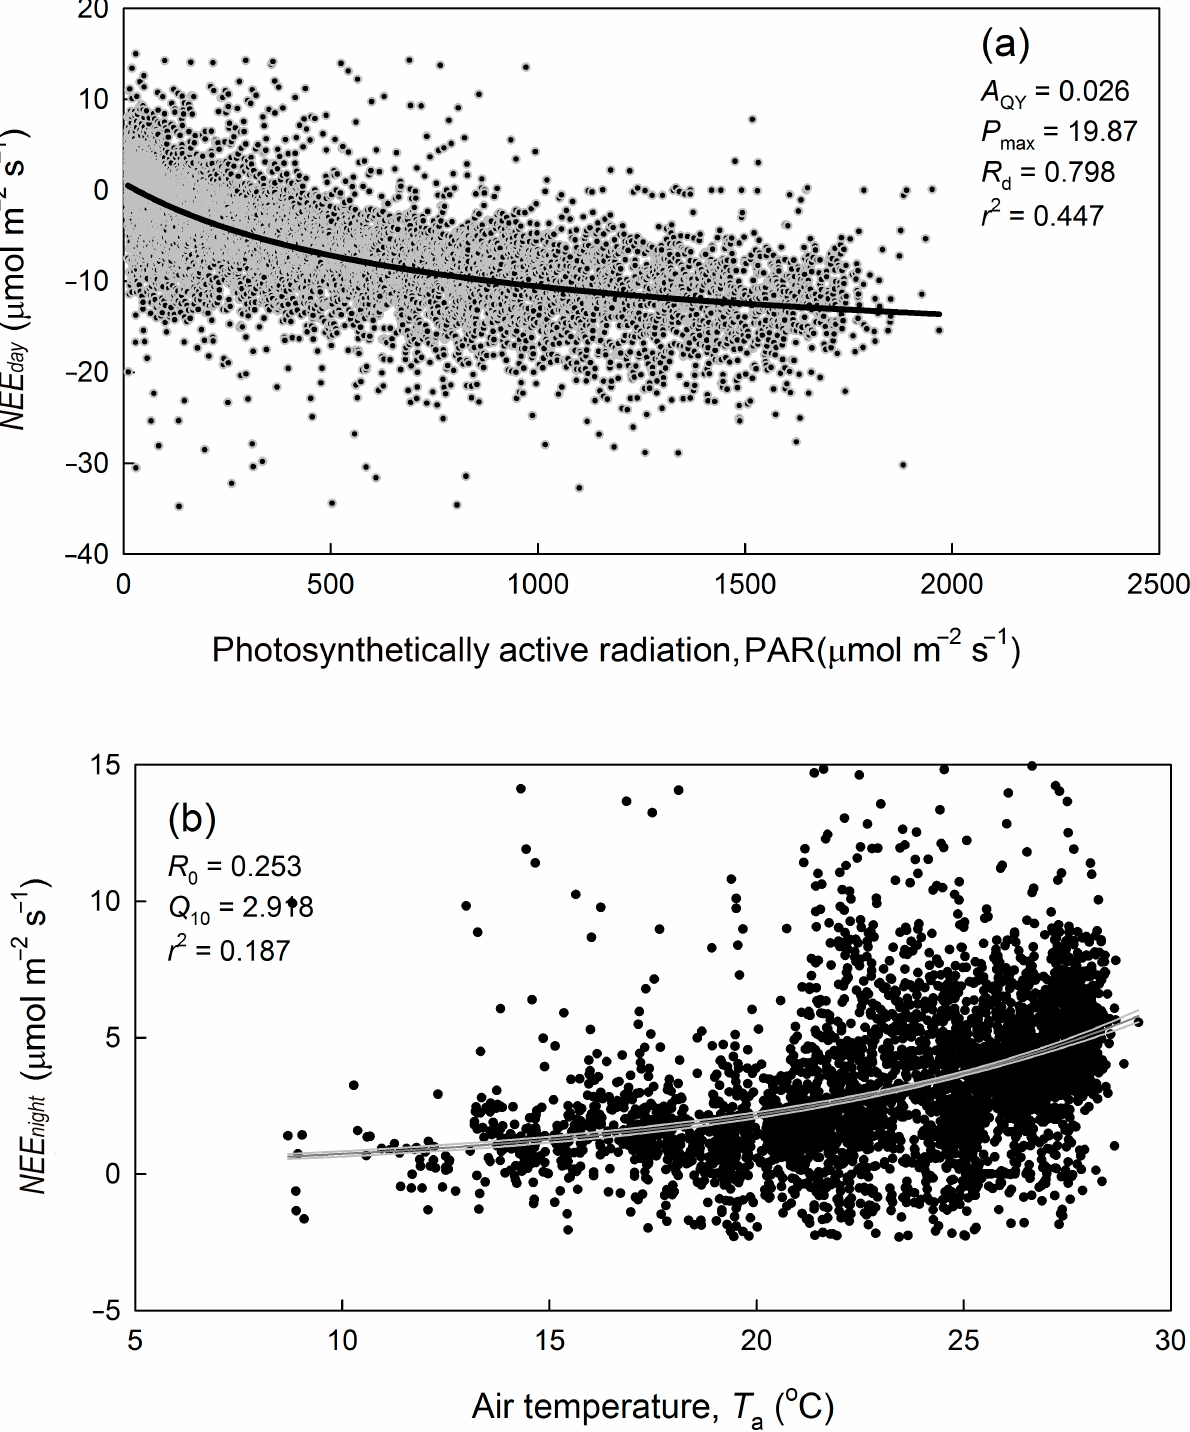
Figure 5. Environmental response of the net ecosystem exchange ( NEE ). ( a ) Light response of the daytime NEE . A nonrectangular hyperbola equation was fitted to the data. ( b ) Temperature response of the nighttime NEE . The Q 10 function was fitted to the data. The lines indicate the linear regression.